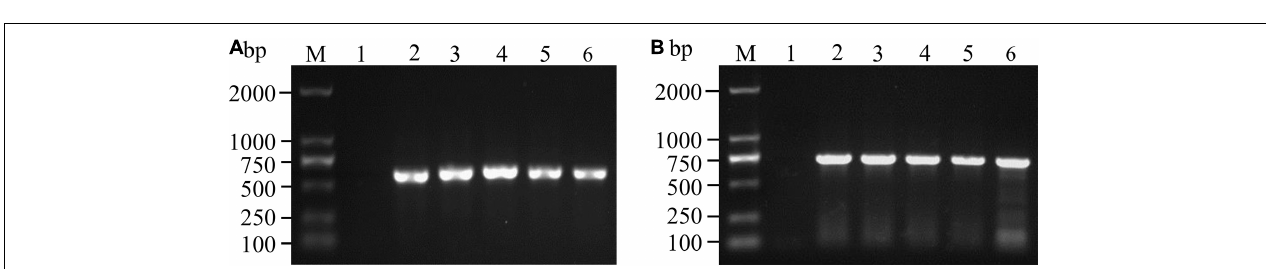
FIGURE 2 | Distribution of Fusarium -infected samples in the Guizhou Province of China. • : no maize sample collected; • : samples without Fusarium infections in these regions; : samples with suspected infections in these regions; • : samples with mild infections in these regions; • samples with moderate infections in these regions; and : samples with severe and extreme infections in these regions.